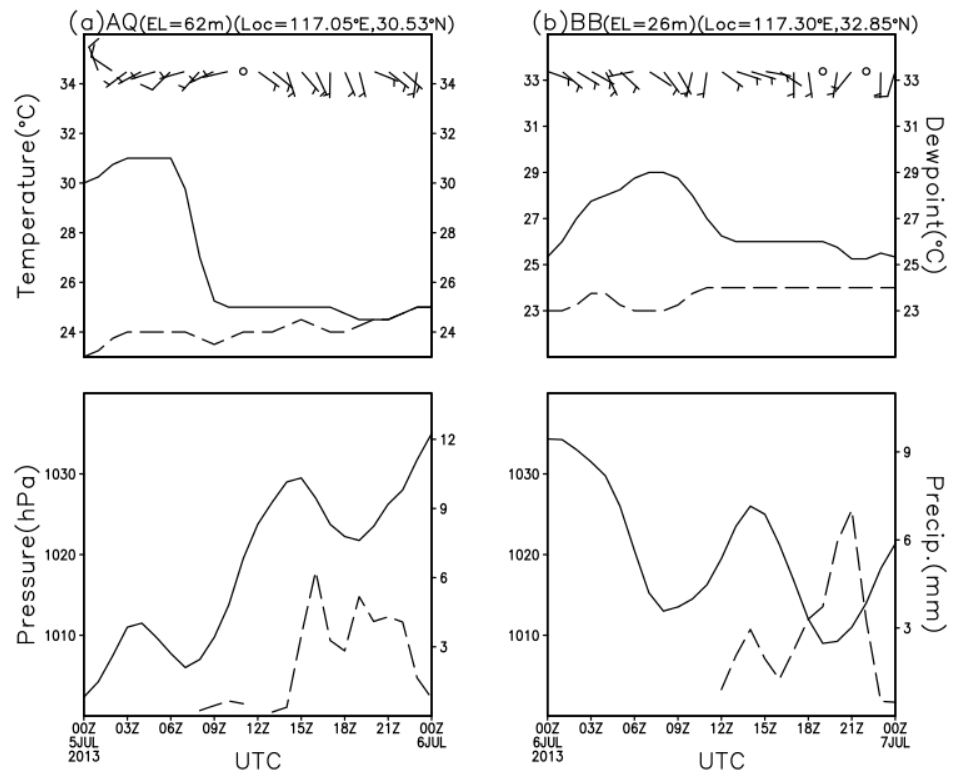
Figure 3. Time series of winds, temperature (solid line, units: °C) and dew point (dashed line, units: °C), surface pressure (solid line, units: hPa) and precipitation (dashed line, units: mm) of ( a ) AnQing (AQ) site on 5 July; and ( b ) BengBu (BB) site on 6 July. Winds are plotted with a full barb of 4 m ⋅ s −1 .